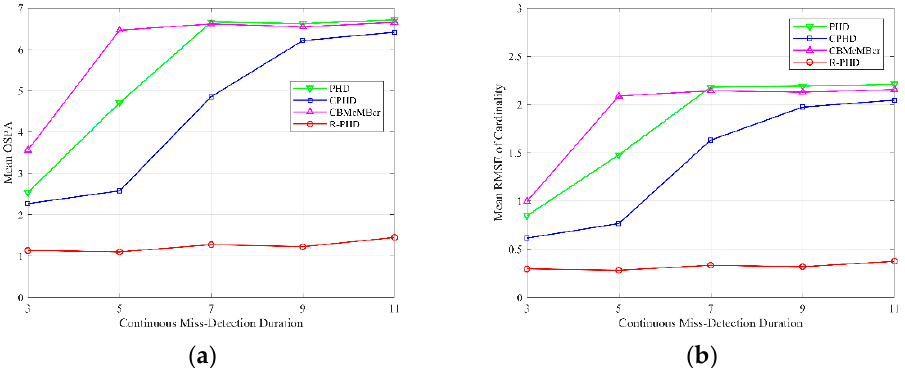
Figure 8. OSPA and cardinality performances of different methods with respect to different continuous miss detection durations from s = 3 to s = 11 ( p D = 0.9, λ = 10): ( a ) mean OSPA; ( b ) mean RMSE of cardinality.